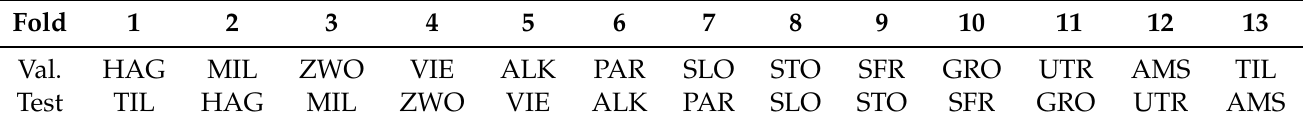
Table 1. Hospitals retained as part of the validation and test sets, per fold, with the leave-one-hospital out protocol. Fold 1 Val.